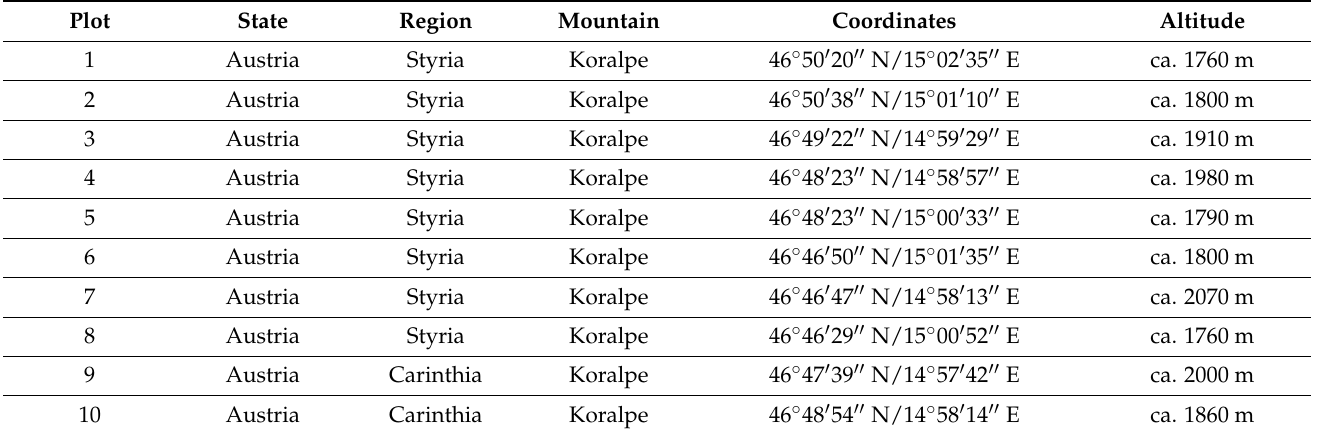
Table 1. Metadata of the collecting sites: plot number, geographic location (state, region), coordinates, and altitude (in meters above sea